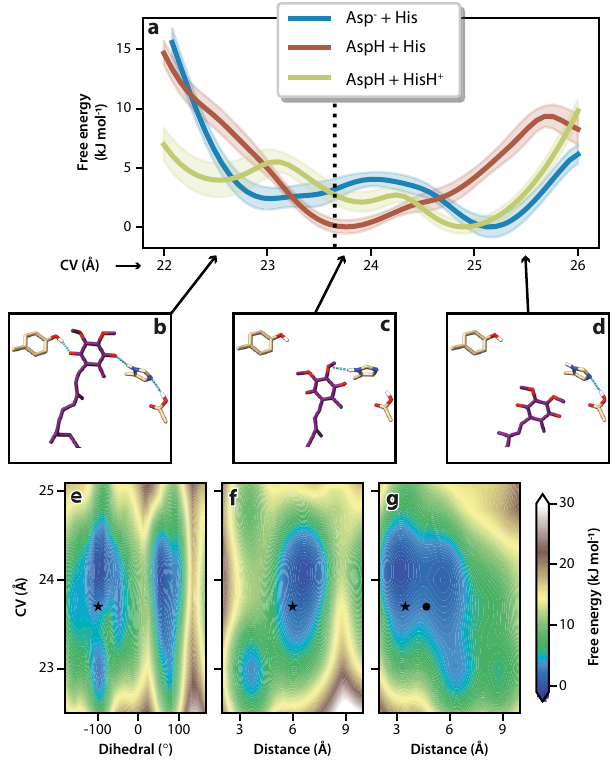
Fig. 3 Free energy pro fi les from molecular dynamics simulations. a Pro fi les were obtained for three combinations of sidechain protonation with Asp160 NDUFS2 ionised (Asp − ) or protonated (AspH) and His59 NDUFS2 neutral (His, N δ 1 -protonated π tautomer) or di-protonated (HisH + , both N δ 1 - and N ε 2 -protonated). The statistical uncertainties in the free energies were estimated as 95% con fi dence intervals by bootstrap analysis and are shown in coloured shadows. The collective variable (CV) describes the Q-headgroup position along the binding channel, as illustrated with His59 NDUFS2 , Tyr108 NDUFS2 and Asp160 NDUFS2 sidechains in b for CV = 22.5 Å, c for CV = 23.8 Å, and d for CV = 25.5 Å. The dashed line in a shows CV = 23.6 Å measured from the active-Q 10 cryo-EM model. Two- dimensional pro fi les for the [AspH + His] charge-state along the CV coordinate and coloured by free energy are shown in e for the His59 NDUFS2 χ 2 dihedral (C β -C γ bond torsion), f for the distance between the His59 NDUFS2 -N ε 2 and Asp160 NDUFS2 -C γ atoms, and g for the distance between the Q-headgroup 3-methoxy-O and His59 NDUFS2 -N δ 1 atoms. Symbols correspond to the structural properties observed in cryo-EM models active-Q 10 with the primary (star) and fl ipped (bullet)